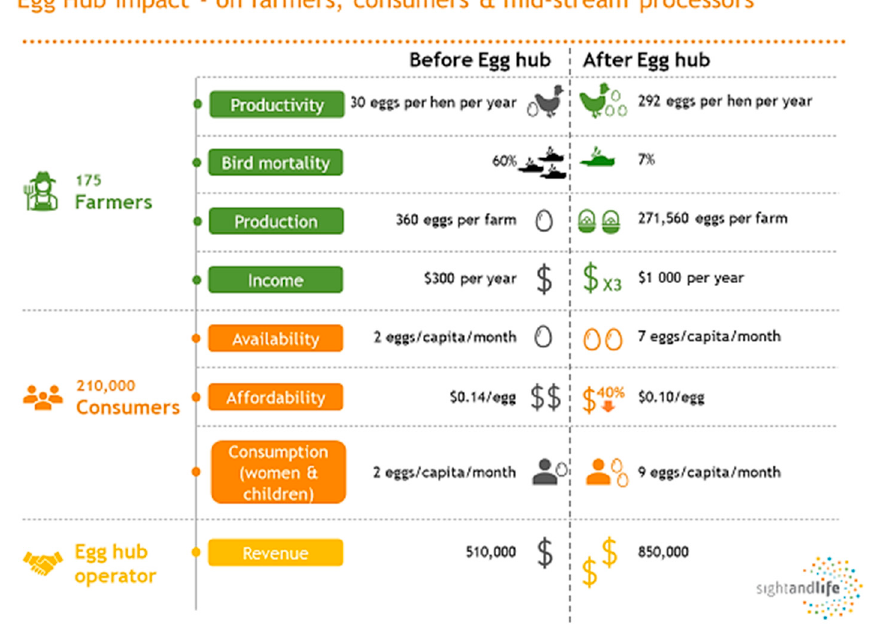
Figure 4. Malawi egg hub impact in 2021.